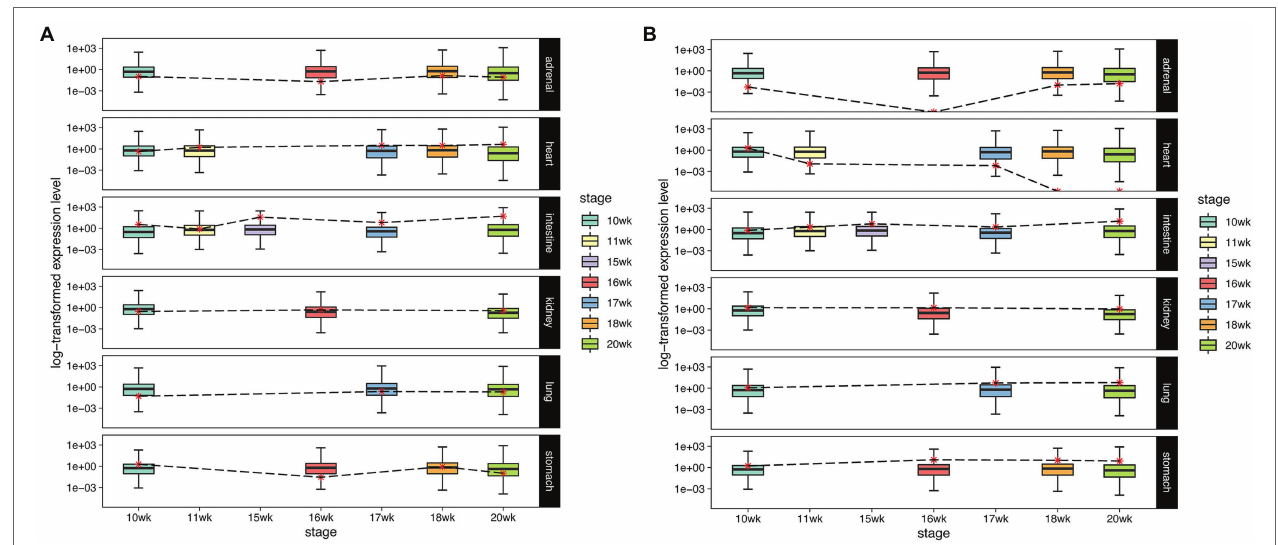
FIGURE 4 | The expression level of SARS-CoV-2 infection-associated factors. The gene expression level in multiple embryonic tissues, the red dots and dotted lines represent the expression level of ACE2 (A) and TMPRSS2 (B) in different stages. The y-axis indicates the normalized expression (log10-transformed FPKM) of